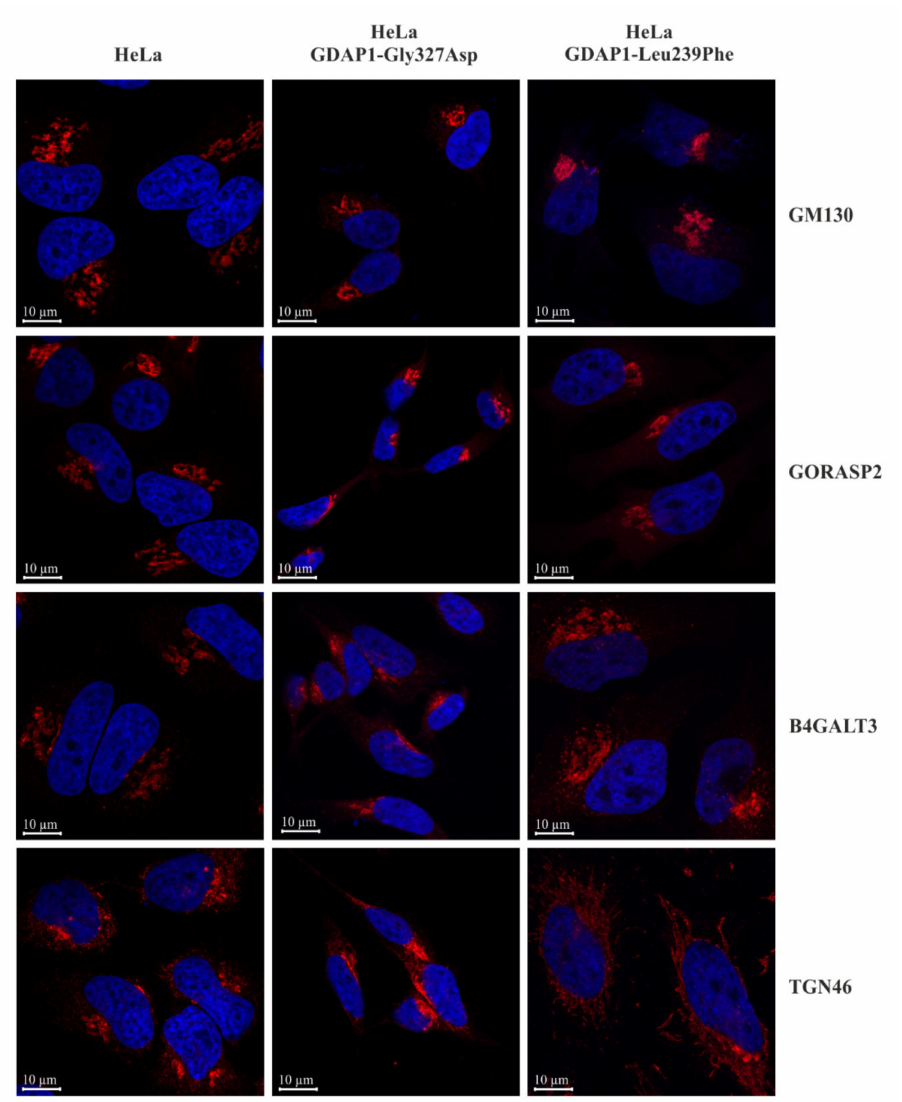
Figure 5. The localization of TGN46, a protein of the trans -Golgi network, is altered in HeLa cells expressing the GDAP1- Leu239Phe allele. The confocal microscopy images show the localization of GM130, GORASP2, B4GALT3 and TGN46 proteins in the control HeLa cells or in HeLa cells expressing the GDAP1-Gly327Asp or GDAP1-Leu239Phe alleles. All proteins were visualized by indirect immunofluorescence. Nuclear DNA was stained with